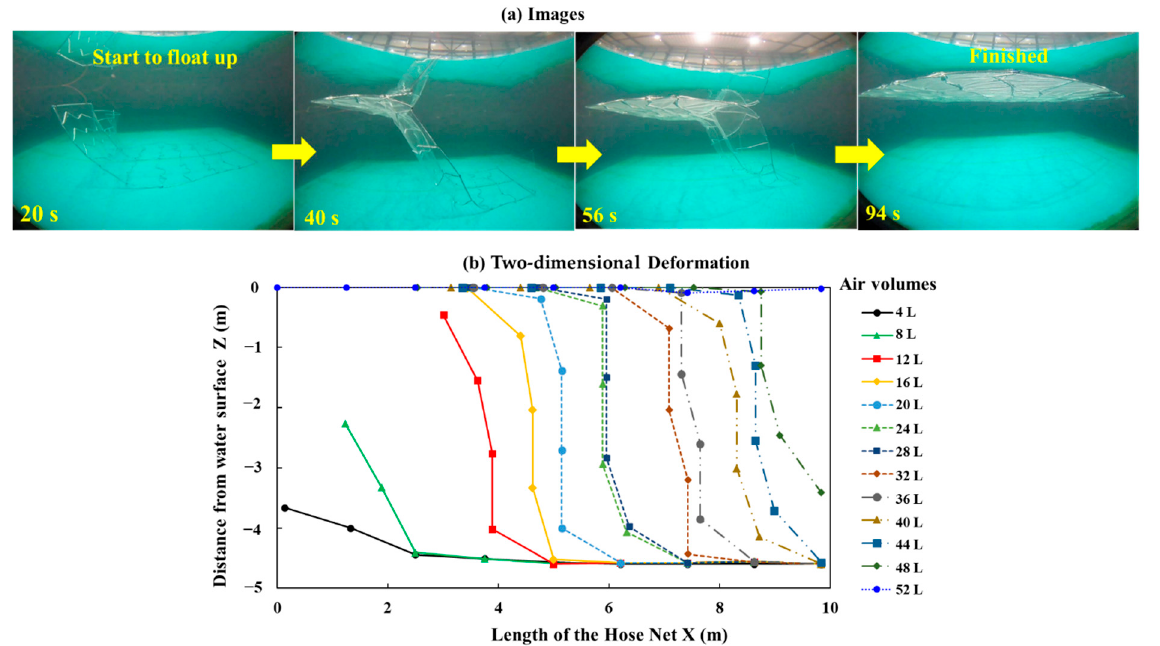
Figure 9. ( a ) Time-series images during the floating up process. ( b ) Two-dimensional deformation with different volumes of air in the floating up process.